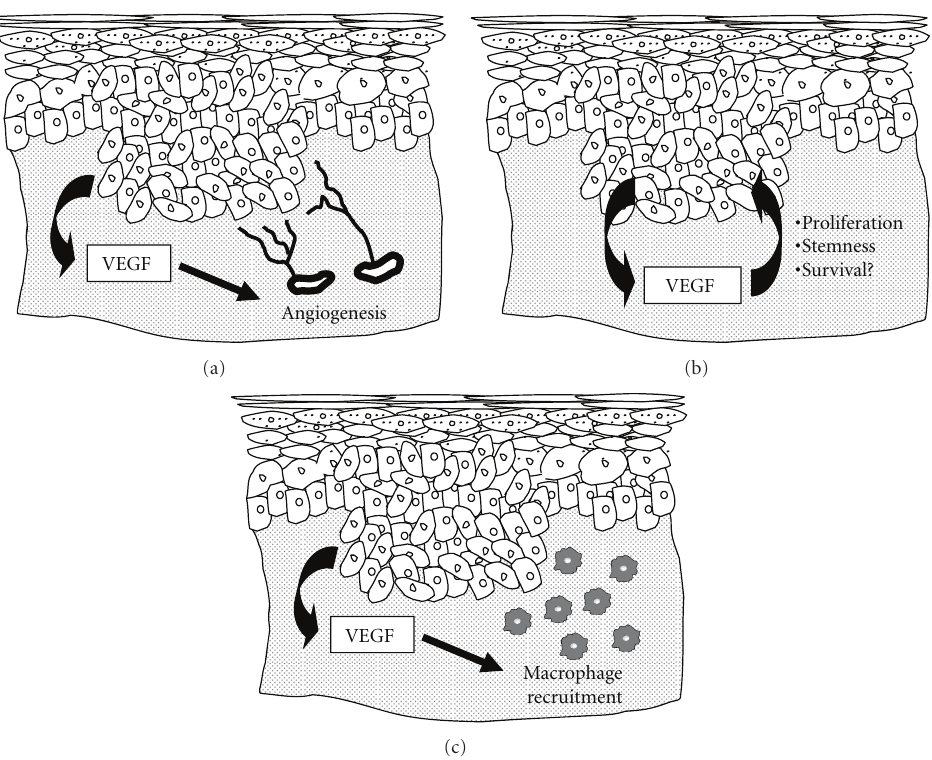
Figure 1: Tumor-promoting actions of VEGF in skin carcinogenesis . Epithelial tumor cells produce large amounts of VEGF in the skin, as depicted by the arrow on the left side of each panel. Traditionally, VEGF has been recognized only for its ability to stimulate angiogenesis through paracrine actions on endothelial cells (a). However, additional functions of VEGF have now been described. Recent studies have suggested that VEGF can a ff ect epithelial cells in an autocrine manner by stimulating proliferation, maintaining stemness, or possibly by promoting survival (b). Additionally, macrophages can be recruited to skin tumors by VEGF through paracrine mechanisms. These macrophages are capable of producing an array of mediators that can support the growth of tumor cells in the